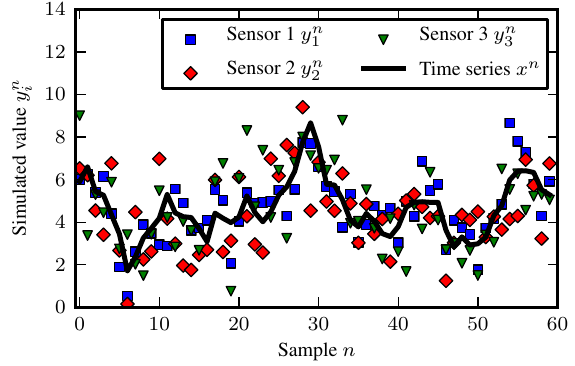
Fig. 2. Estimated variance ˆ σ ii as function of the number of samples N . The solid lines indicate the ± 2SE range (around the actual value), as determined from Eq. (14).